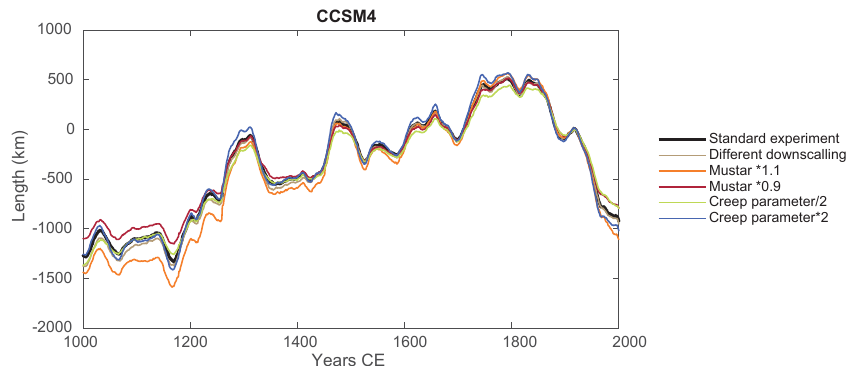
Figure 7. Length changes averaged over the 71 glaciers for the standard and sensitivity experiments using CCSM4